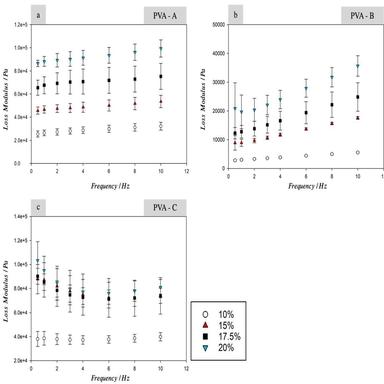
Loss modulus for PVA-A (a), PVA-B (b), and PVA-C (c), at concentrations of 10, 15, 17.5 and 20% w/w. Error bars show 95% confidence intervals (n = 6).